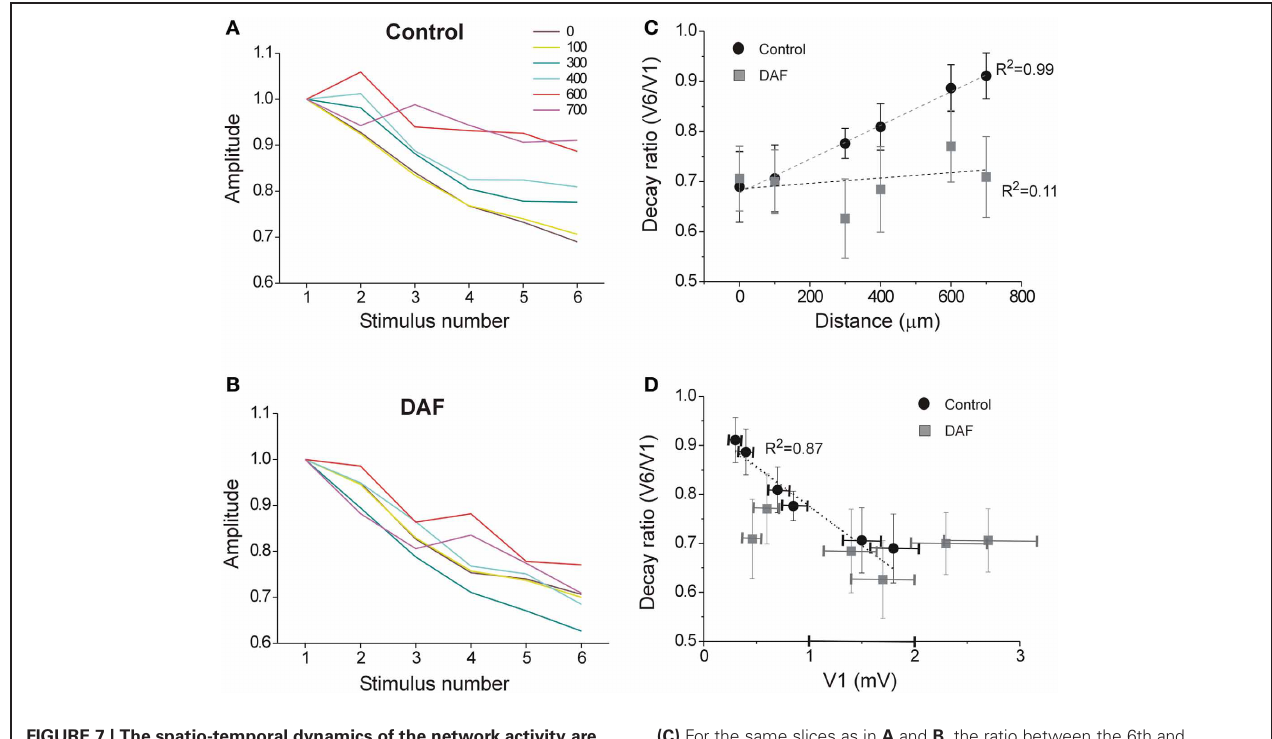
FIGURE 7 | The spatio-temporal dynamics of the network activity are disrupted in DAF-treated slices. A train of six stimuli at 40Hz was delivered under the first electrode, and LFPs were recorded in layer 2/3 at six horizontal distances (color-coded as marked). (A) LFP depression with frequency is displayed for the six distance points in control slices. Each line displays an average of 10 slices (error bars omitted for clarity). (B) LFP depression with frequency is displayed for six distance points in DAF-treated slices. Each line displays an average of 11slices.